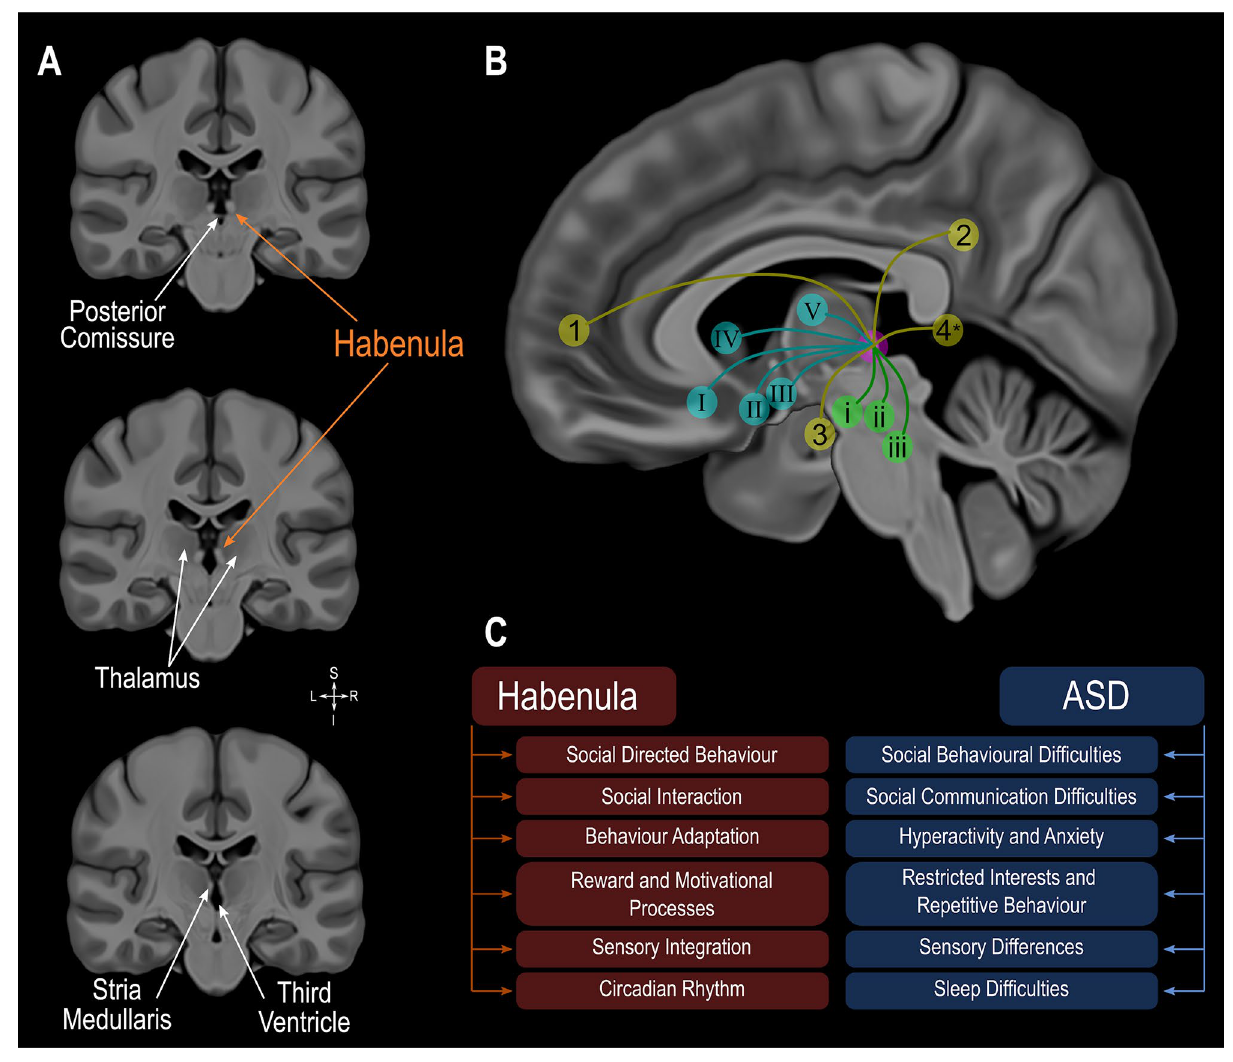
appearing bright (hyperintense) on T1 weighted magnetic resonance images, surrounding structures and its boundaries. ( B ) Diagram illustrating the connectivity of the habenula. Cortical regions in yellow: (1) medial prefrontal cortex; (2) cingulate gyrus; (3) hippocampus and parahippocampal gyrus; (4) posterior insula (*estimated location). Subcortical regions in blue: (I) basal forebrain; (II) hypothalamus; (III) nucleus basalis of Meynert; IV, basal ganglia; V, thalamus. Brainstem regions in green: (i) ventral tegmental area; (ii) substantia nigra; (iii) periaqueductal grey—raphe nuclei. ( C ) Functions that the Habenula is critically involved in